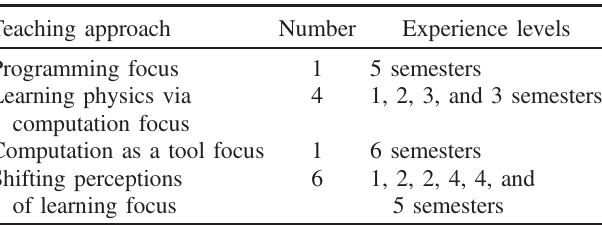
TABLE XV. Number of learning assistants most aligned with each teaching approach and their experience